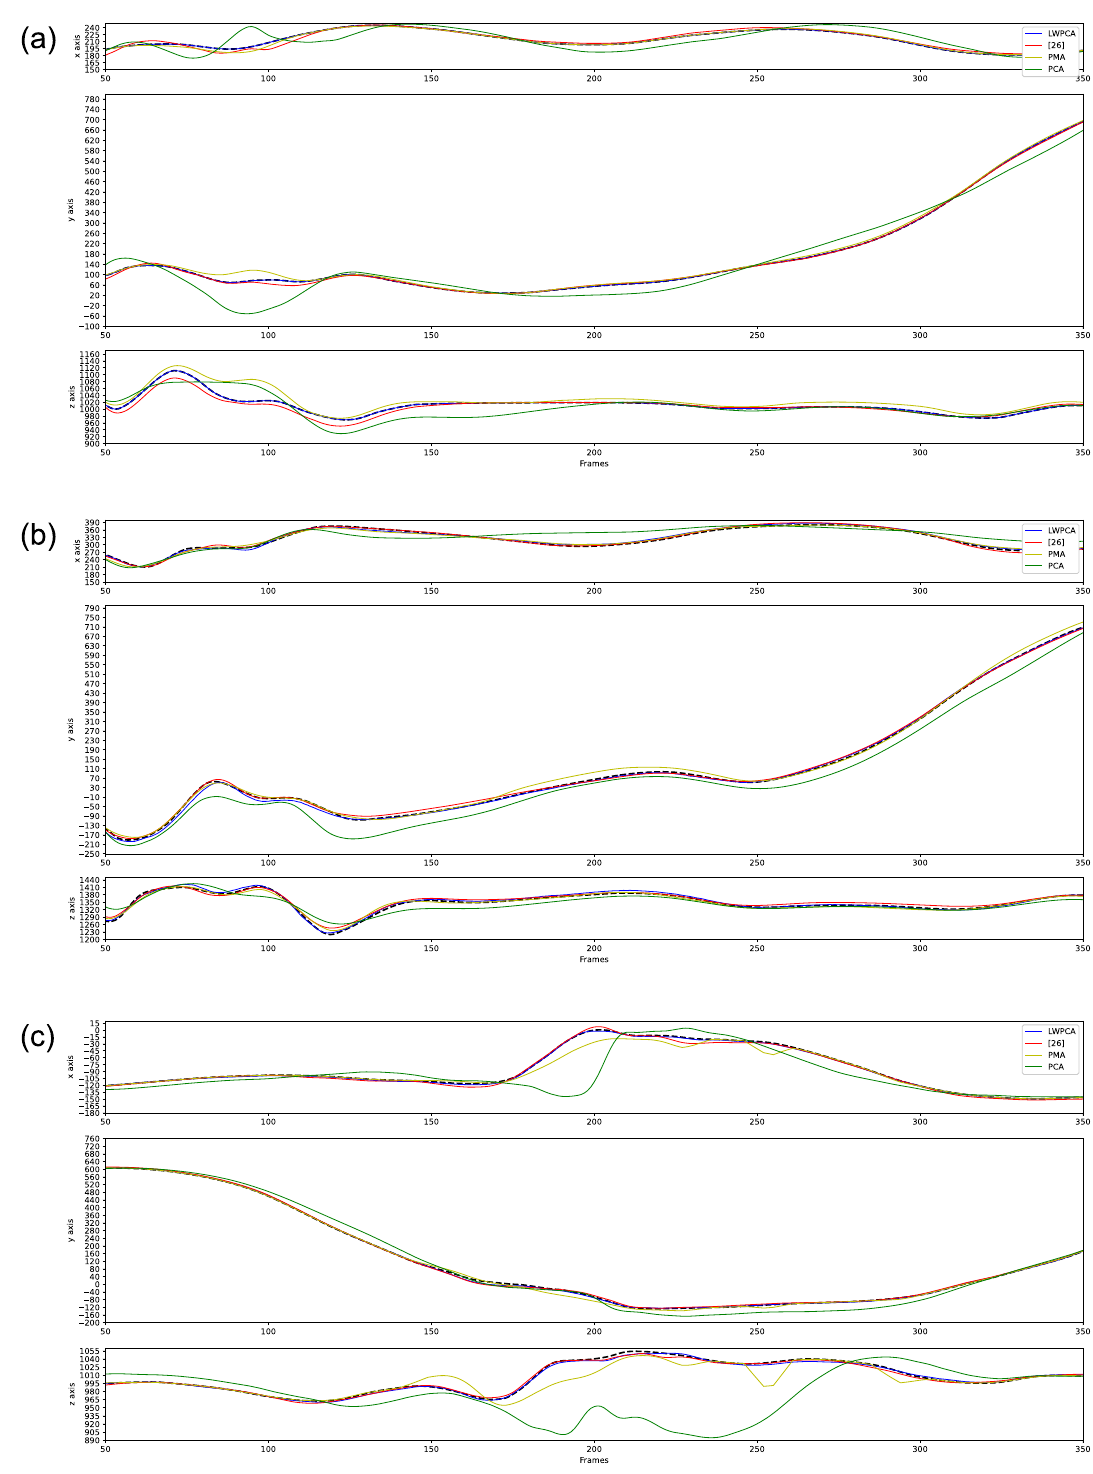
Fig 4. Reconstruction of the trajectory of joint-33 in the scenarios of missing 3,6 and 9 markers. Dotted lines represent the ground truth trajectories of the joint-33.